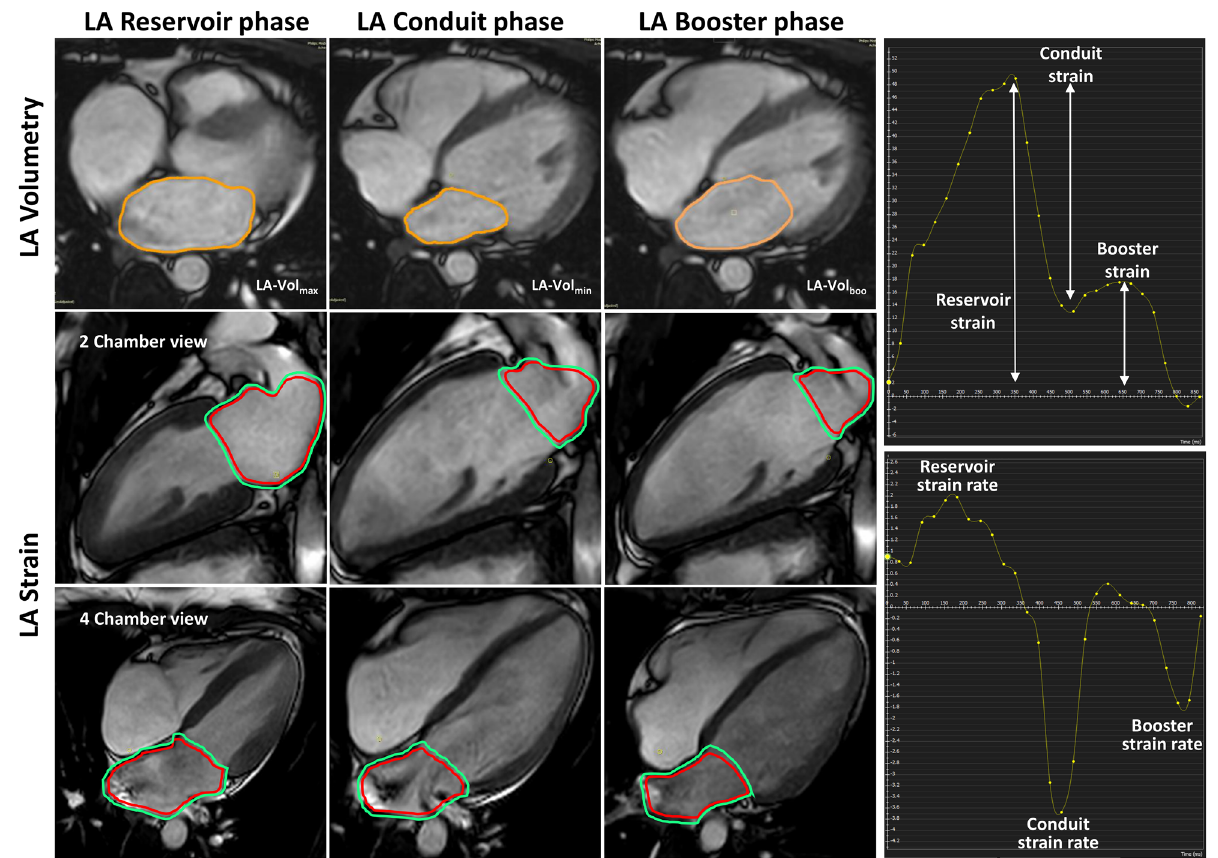
Figure 3. Measurement of left atrial longitudinal strain and strain rate in a 24-year-old healthy female. Upper row: Determination of left atrial chamber volumes in the reservoir, conduit and booster cardiac phase, respectively. The entire axial stack of slices was used for the volume calculations. Accordingly, endocardial (red) and epicardial (green) left atrial contours are shown in the two-chamber view (middle row) and in the four- chamber view (lower row) for strain estimation in the corresponding cardiac phases. Upper right: Left atrial strain curve. Lower right: Left atrial strain rate curve.